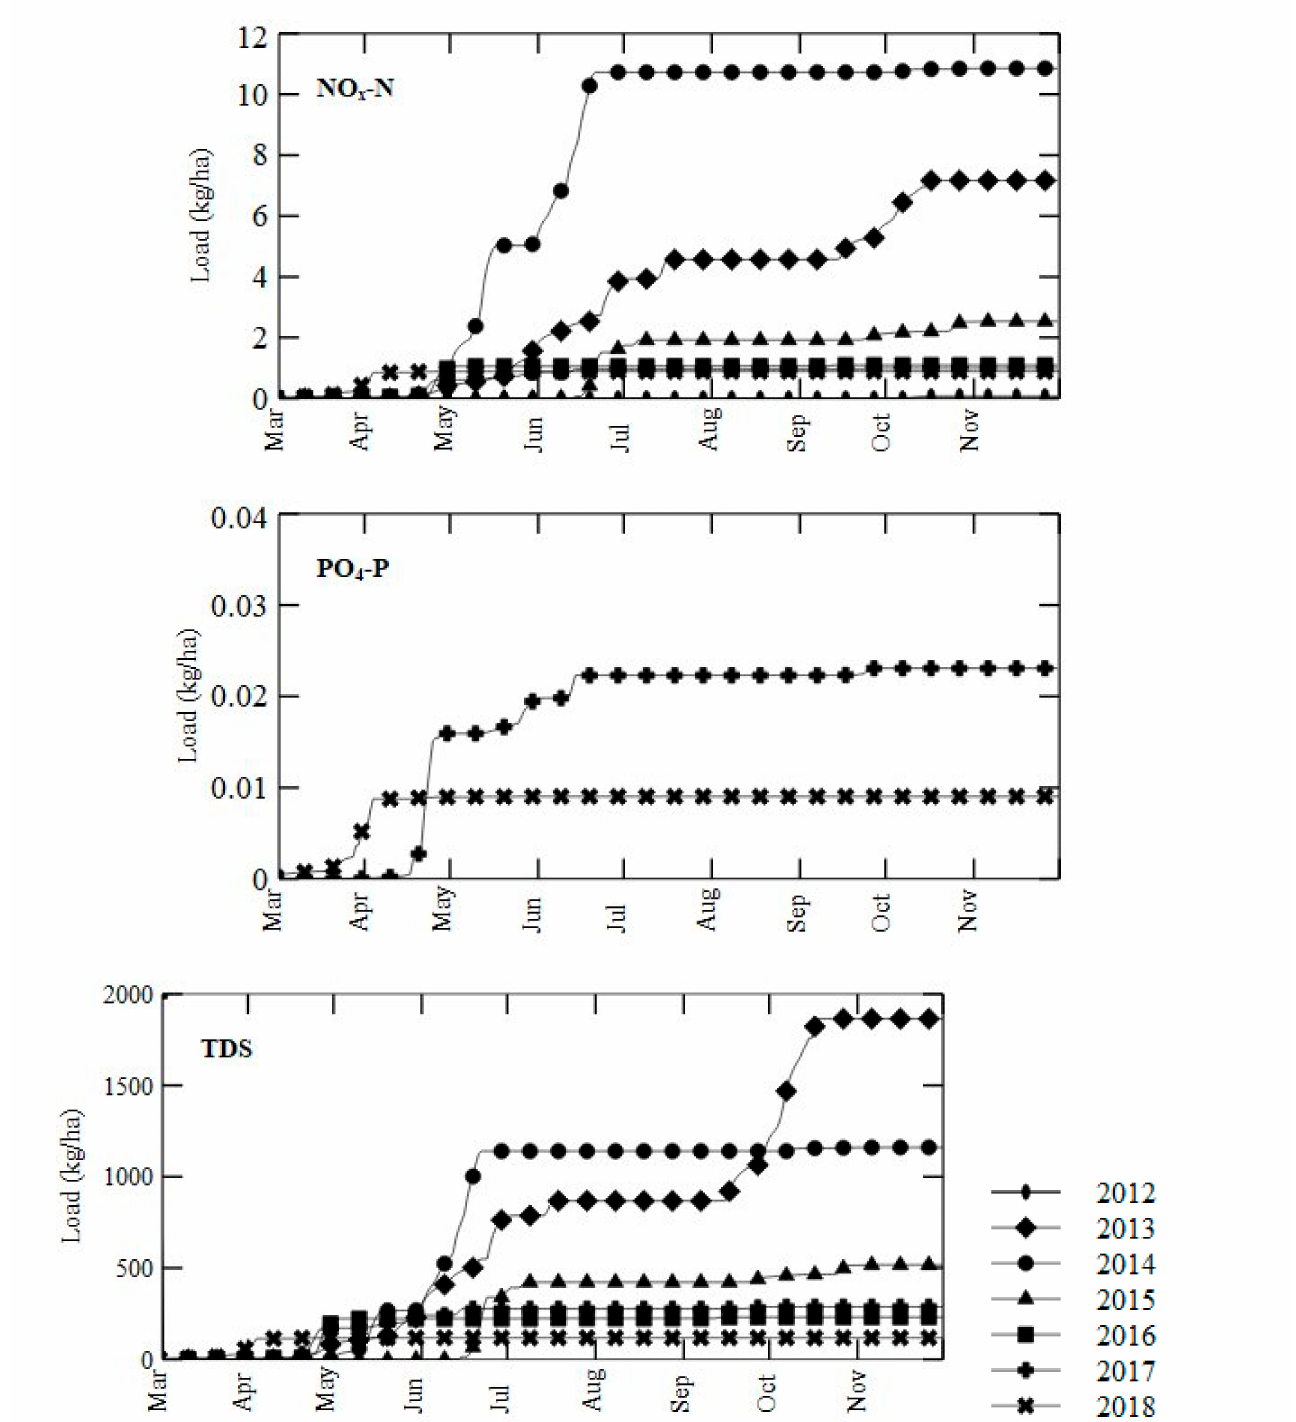
Figure 3. Cumulative nitrite + nitrate nitrogen (NOx-N), orthophosphate (PO 4 -P), and total dissolved solids (TDS) loads from the east sump. Orthophosphate concentration data were not collected prior to September 2016, so only data from 2017 and 2018 are